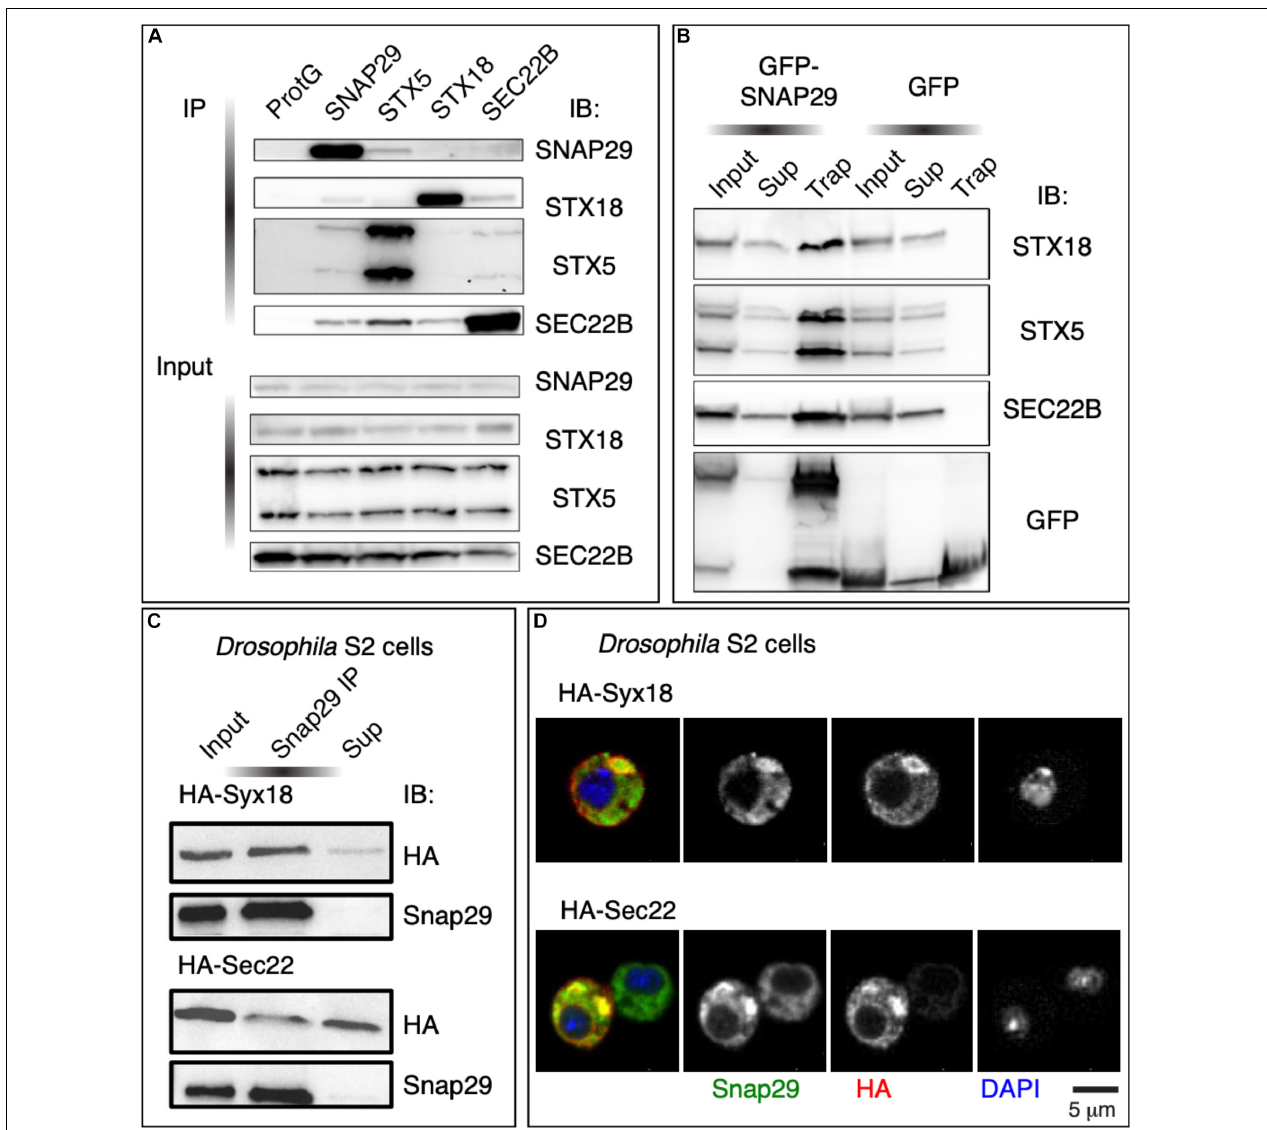
FIGURE 4 | SNAP29 interacts with the endoplasmic reticulum (ER) and the Golgi apparatus (GA) SNAREs. (A) Immunoblotting of proteins immunoprecipitated from HeLa protein extracts with the indicated antibodies and related inputs. Endogenous SNAP29 interacts with the ER and GA SNAREs STX18, STX5, and SEC22B. (B) Immunoblotting of proteins immunoprecipitated using GFP Trap from protein extracts of HeLa cells expressing GFP–SNAP29 or GFP as a control and related inputs and supernatants. GFP–SNAP29 interacts with the ER and GA SNAREs. (C) Immunoblotting of protein extracts from Drosophila S2 cells over-expressing the indicated transgenes immunoprecipitated with the indicated antibody and related controls. Endogenous Drosophila Snap29 interacts with HA-Syx18 and HA-Sec22. (D) Drosophila S2 cells over-expressing the indicated transgenes and stained as indicated. Endogenous Drosophila Snap29 colocalizes with HA-Syx18 and